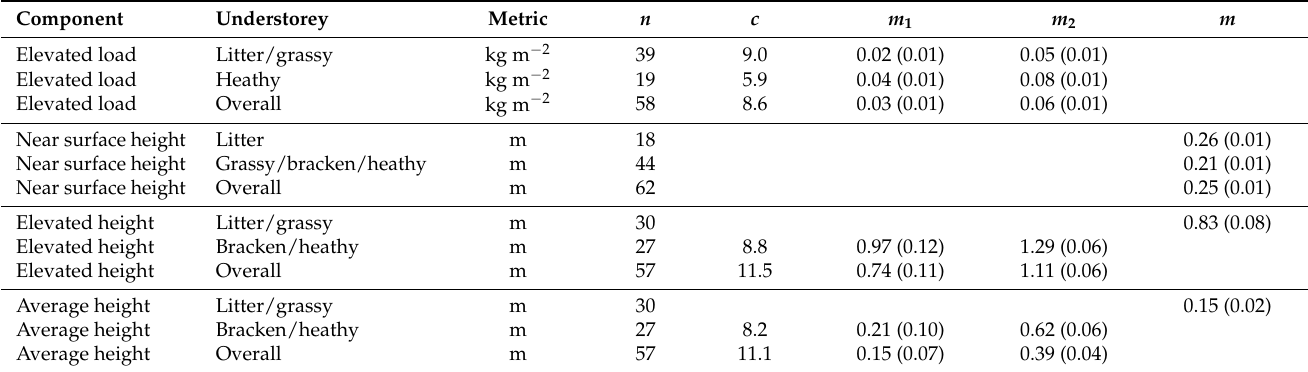
m 2 and m is the mean when there is no critical